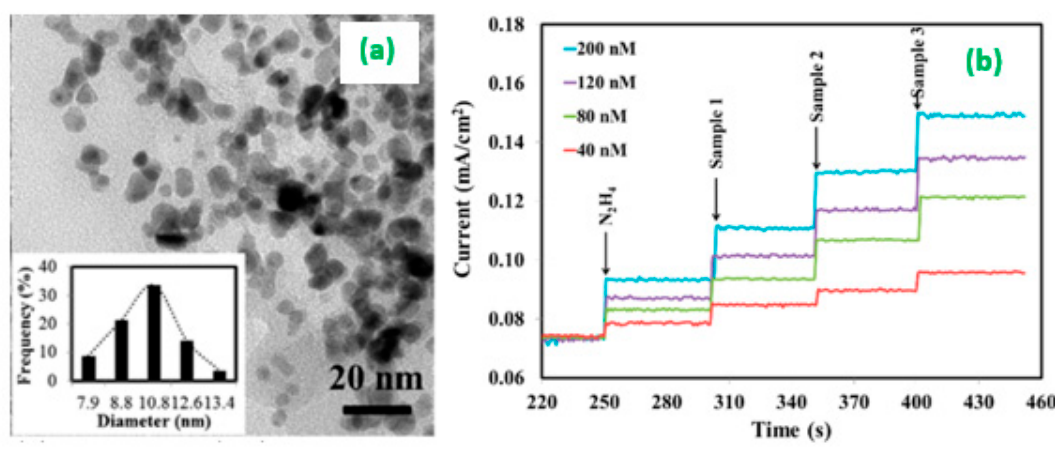
Figure 3. ( a ) TEM images of PdNPs / rGO nanocompostie and ( b ) chronoamperomograms of the PdNPs / rGO RDE at a rotation rate of 6000 rpm with consecutive sample injections. Reproducedfrom